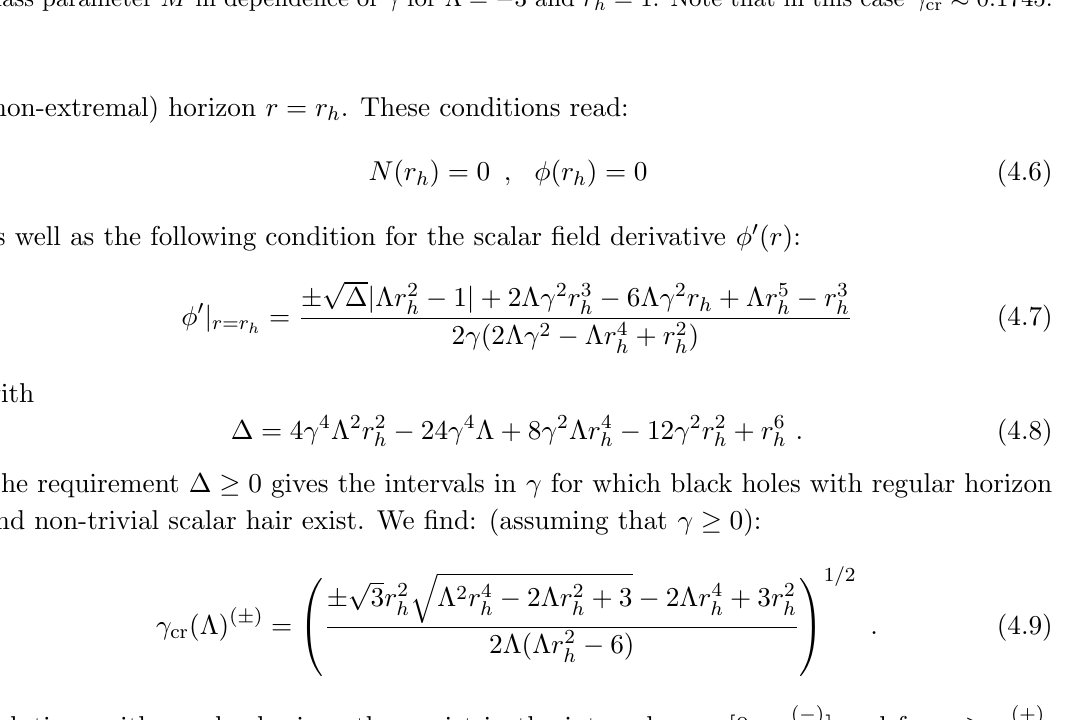
Figure 4 . We show the temperature T H , the constant C 2 (see (2.12)), (cid:0) (cid:30) 0 mass parameter M in dependence of (cid:13) for (cid:3) = (cid:0) 3 and r h = 1. Note that in this case (cid:13) cr (cid:25) 0 :